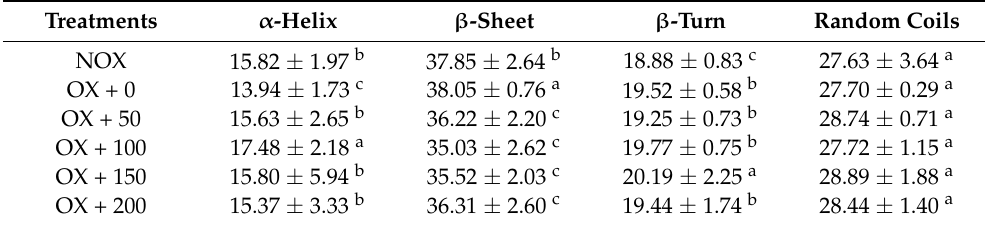
Table 2. Secondary structures of MPs treated with various concentrations of FOs (0, 50, 100, 150, and 200 µ mol/g protein) under nonoxidizing (NOX) or oxidizing (OX) conditions. Different lowercase letters indicate significant differences ( p < 0.05).